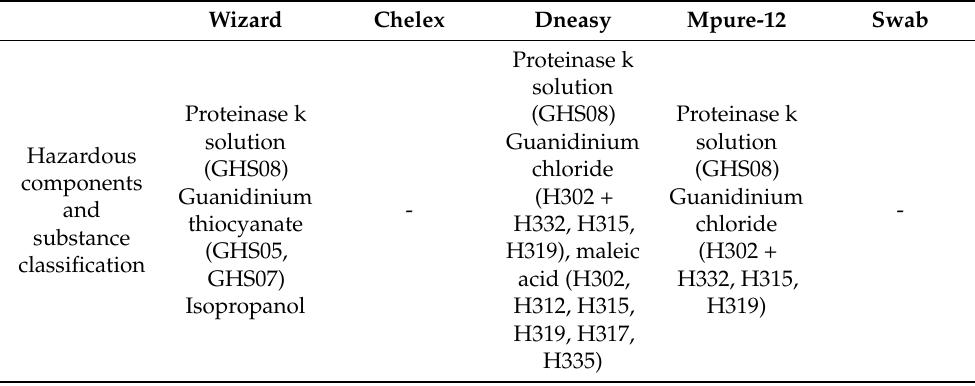
Table 5. Hazardous components and substance classification of the DNA extraction